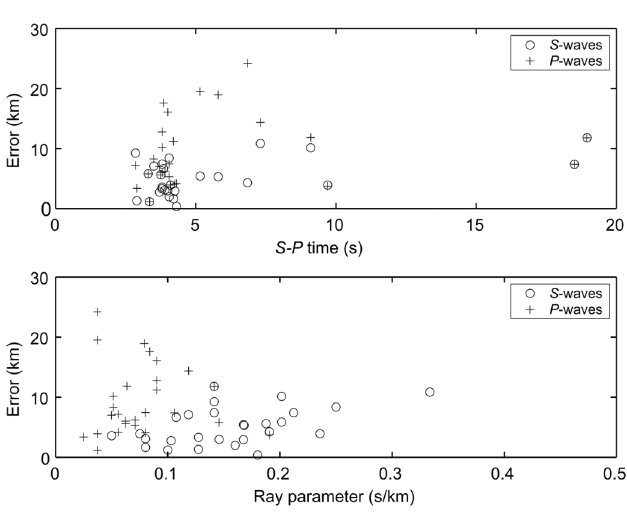
Fig. 15. Location discrepancies as a function of epicentral distance ( top ) and ray parameter ( bottom ) from both P- and S- waves